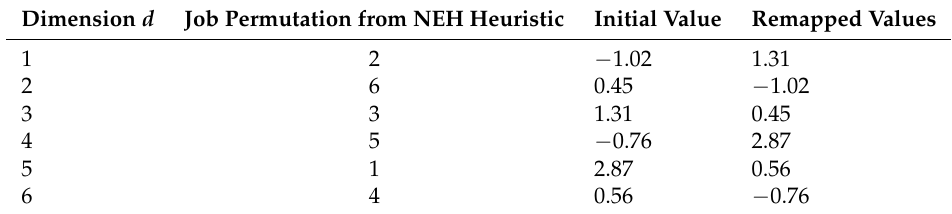
Table 2. Mapping a job permutation to position